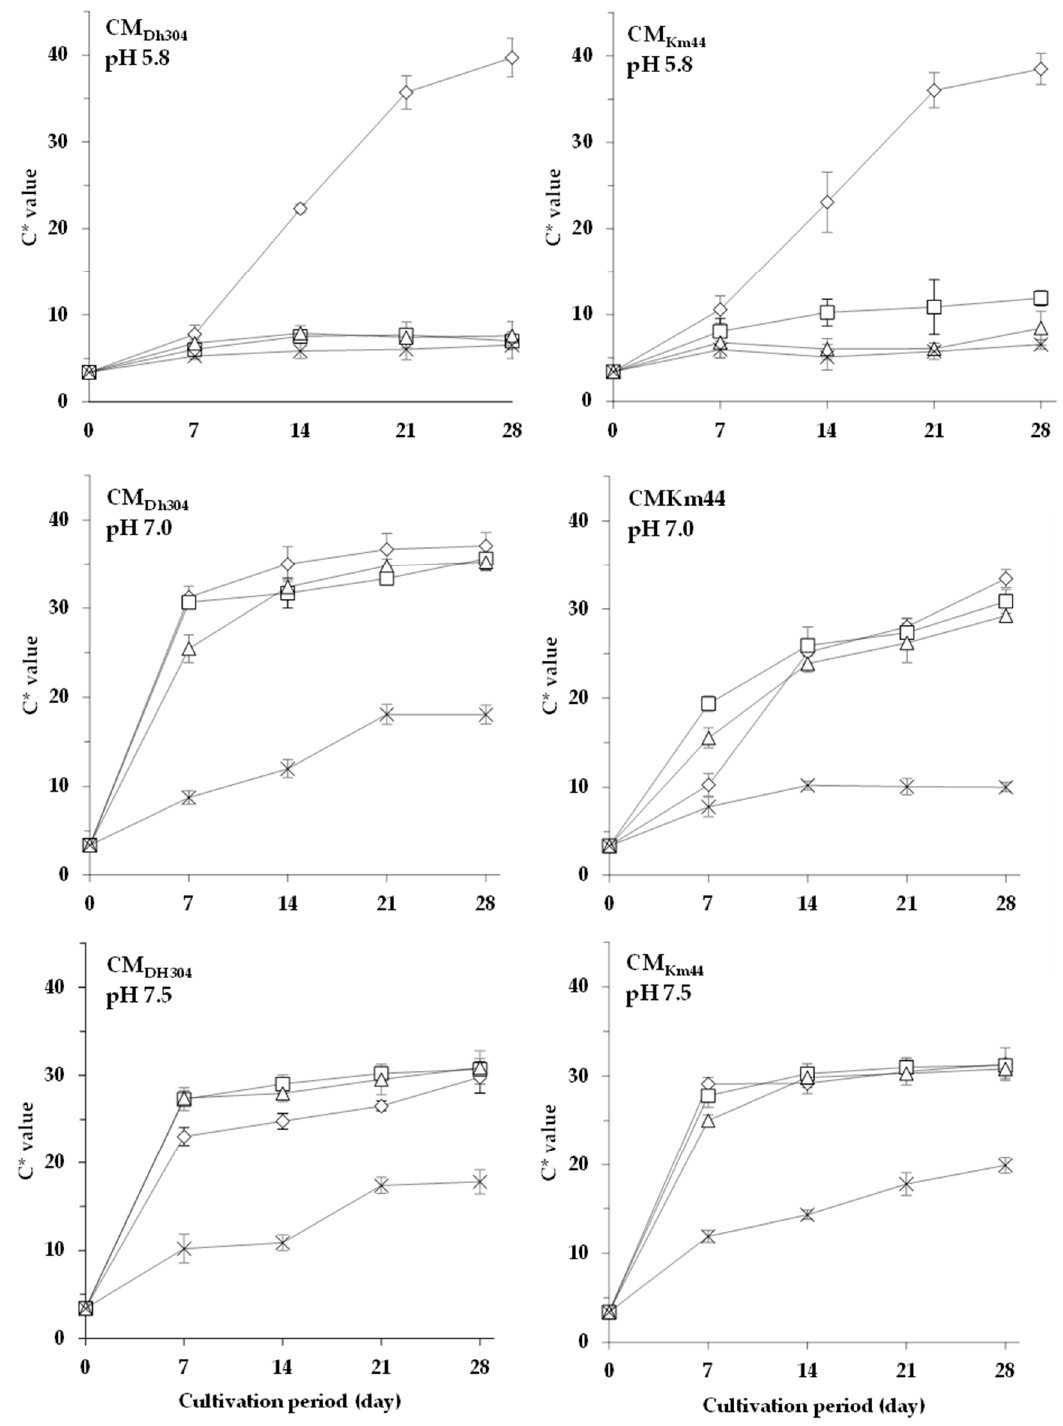
Figure 2. Detailed positions of Arthrobacter arilaitensis Po102 cultures when projected in the CIE L*a*b* colorimetric scale (bars indicate standard deviations) after day (d) 28 incubation. The concentration of additional NaCl (w/v) is presented in colors as follows: 0% ( ), 2% ( ), 4% ( ), and 8% ( ).